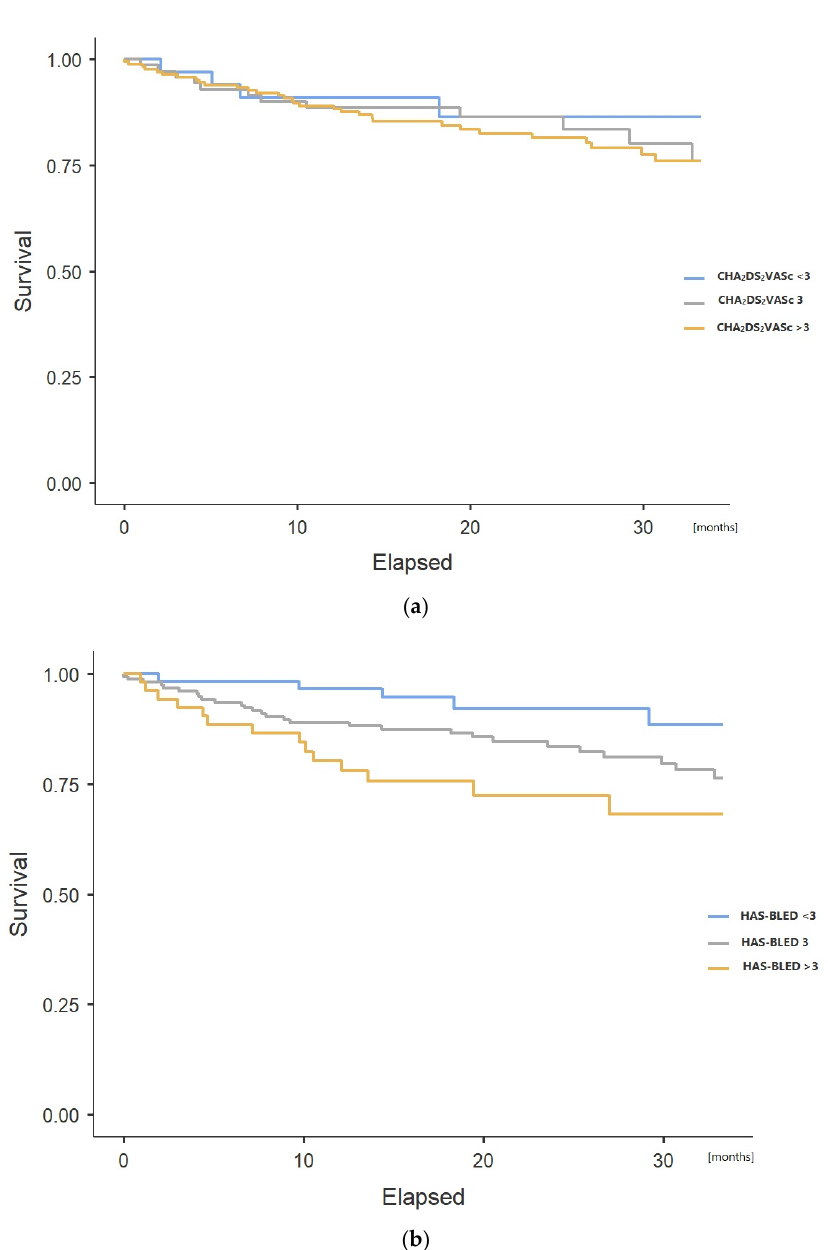
Figure 2. Kaplan–Meier probability of death in subgroups split according to different CHA 2 DS 2 CVASc (congestive heart failure; hypertension; age ≥ 75 years [doubled]; type 2 diabetes; previous stroke, transient ischemic attack, or thromboembolism [doubled]; vascular disease; age 65 to 75 years; and sex category) ( a ) and HAS-BLED (hypertension; abnormal renal / liver function; stroke; bleeding history or predisposition; labile INR, elderly, drugs / alcohol concomitantly) scores ( b